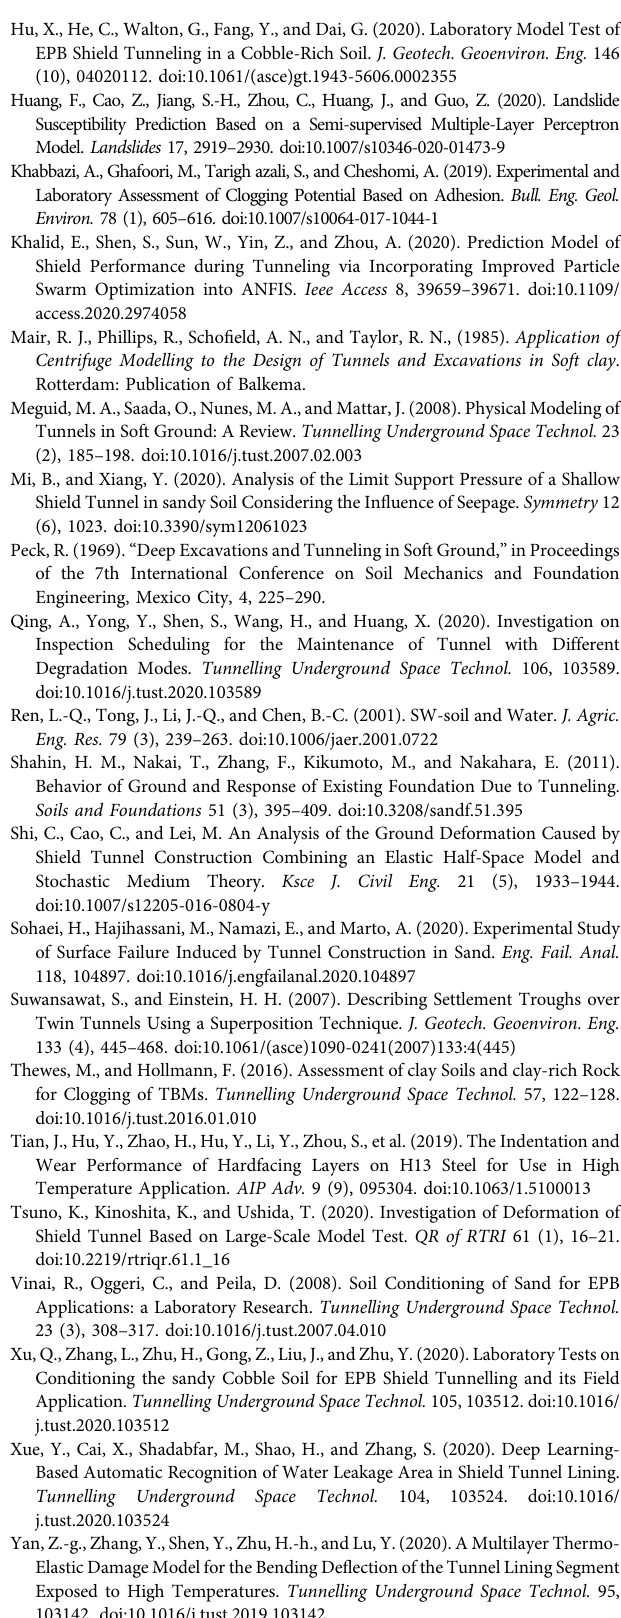
ElasticDamageModelfortheBendingDe fl ectionoftheTunnelLiningSegment Exposed to High Temperatures. Tunnelling Underground Space Technol. 95, 103142. doi:10.1016/j.tust.2019.103142